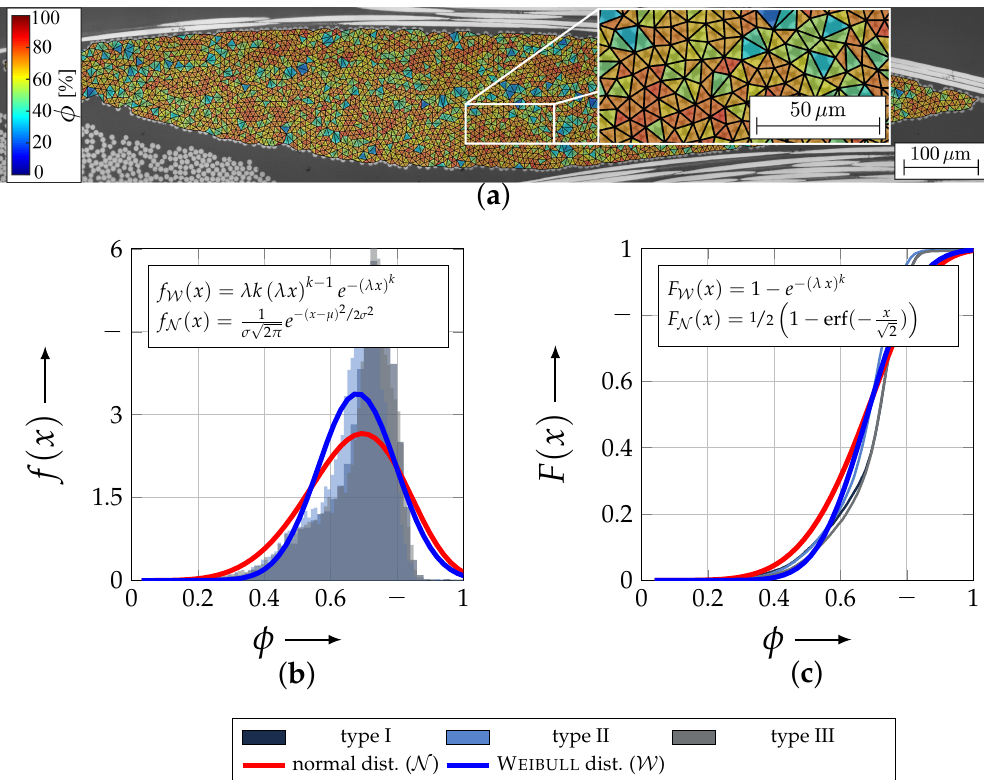
Figure 11. ( a ) Illustration of results of proposed algorithm for type III material; ( b ) histogram for each fabric type’s FVC ( φ ) and fit of different probability density functions ( f ( x ) ) over all data; ( c ) illustration of the cumulative probability functions ( F ( x )